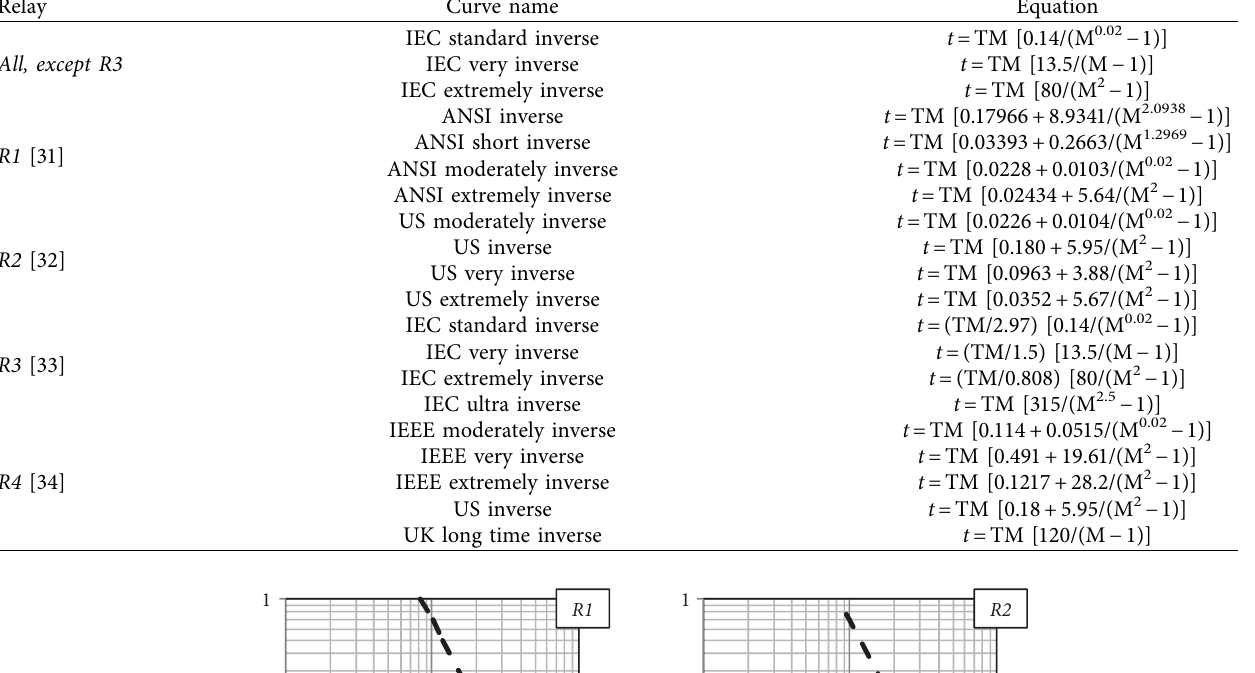
Table 2: Equations of tested inverse-time curves.